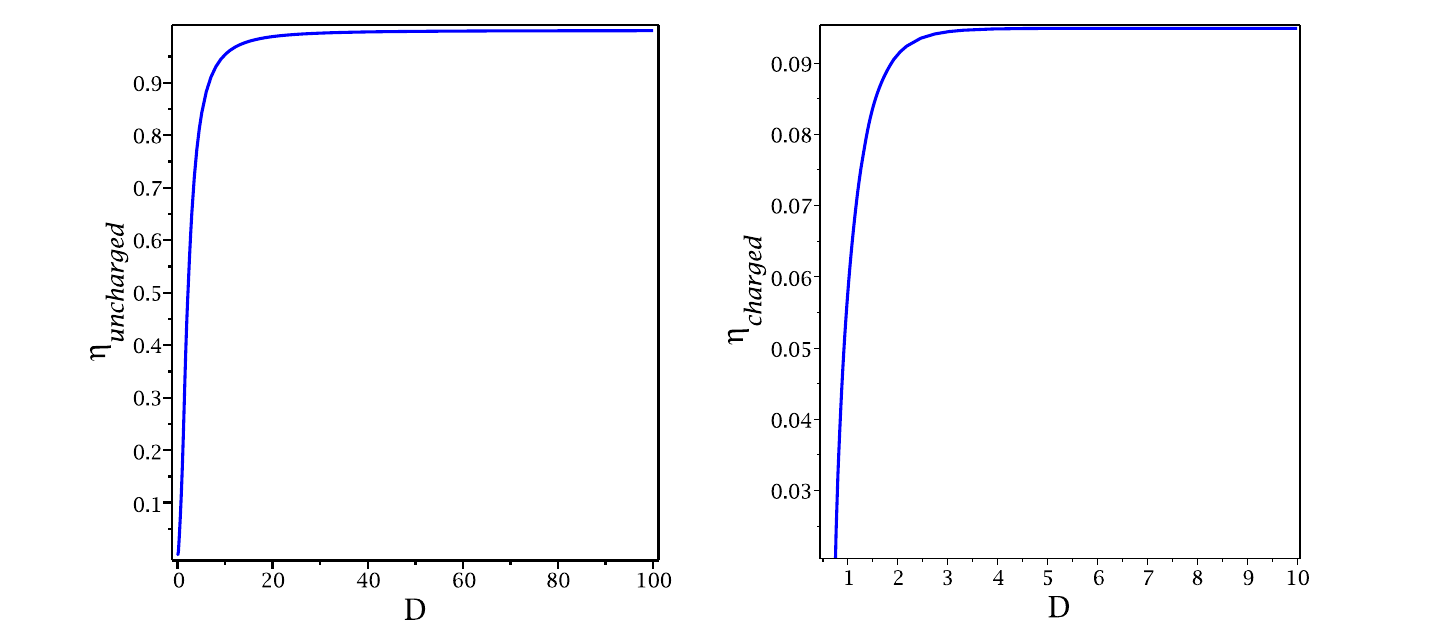
Fig. 17 η charged vsradius D .Wehavechosen m 0 = − 80, L (ε) = 1 . 1, H (ε) = 1 . 1, σ 0 = 4, C 0 = 1, (cid:8)(ε) = − 1, m = 1, q = 1, and l =